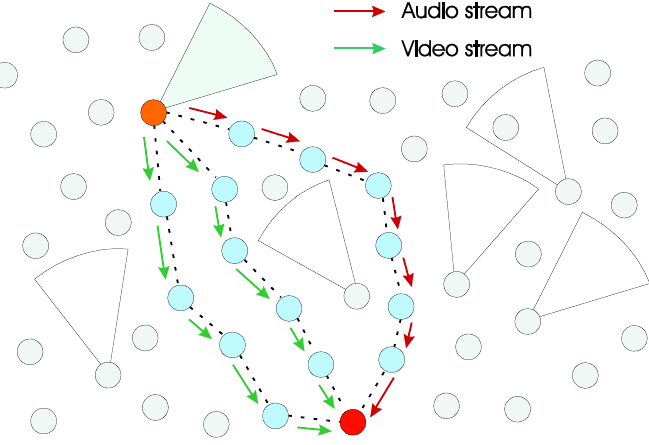
Figure 2. Multipath multimedia transmission through three node-disjoint